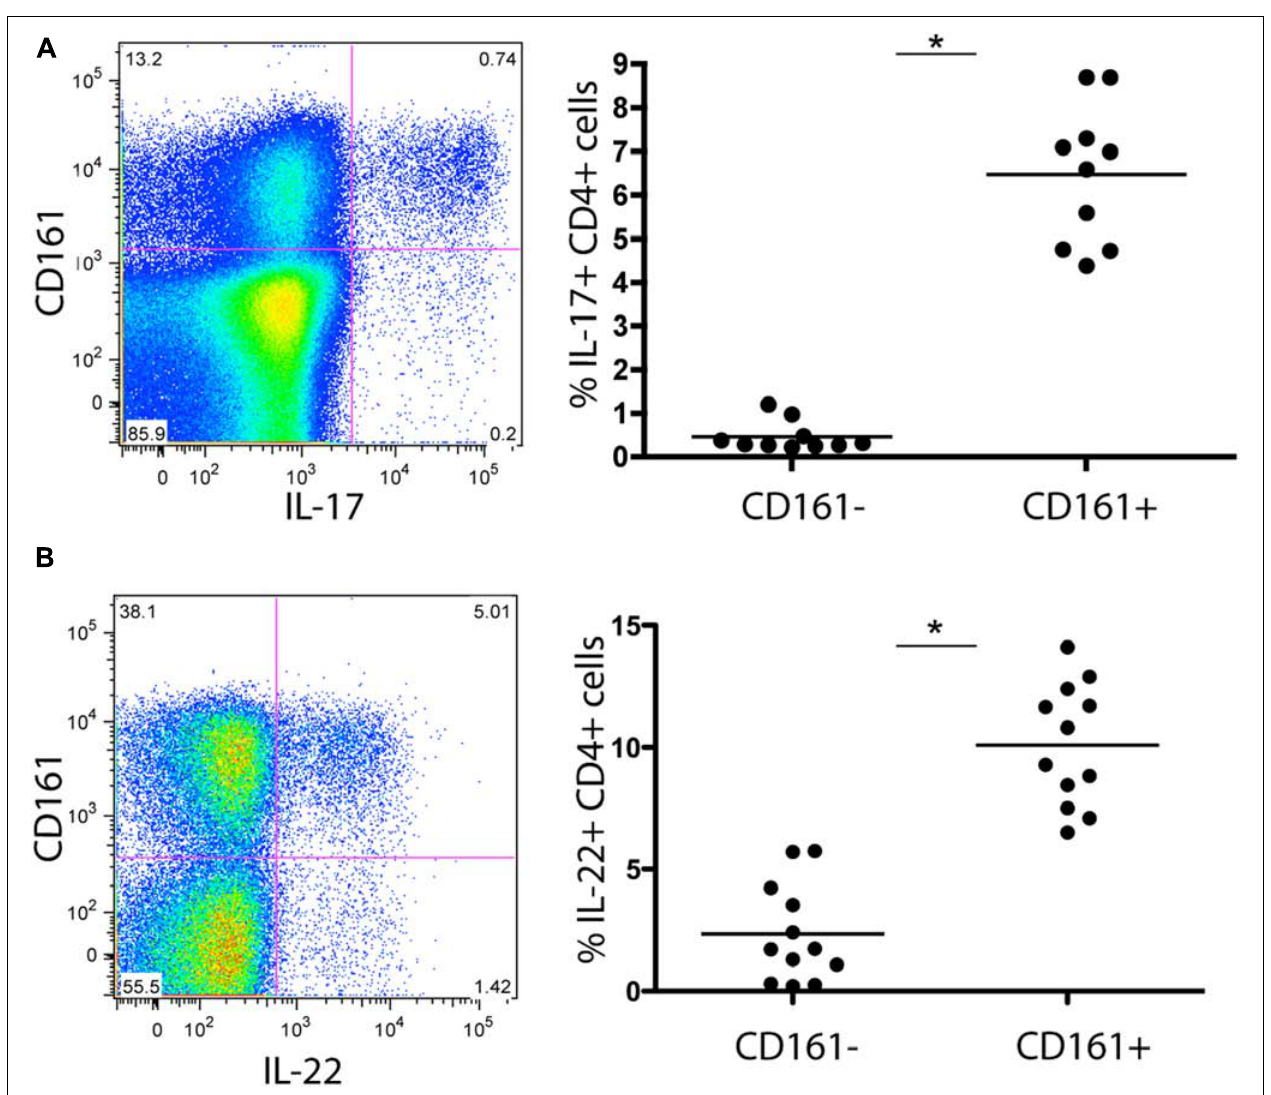
FIGURE 1 | Cytokine secretion capacity of CD161 + CD4 + T cells in healthy donor blood. Healthy donor blood ex vivo was stained as described in methods and analyzed for expression of the following cytokines following